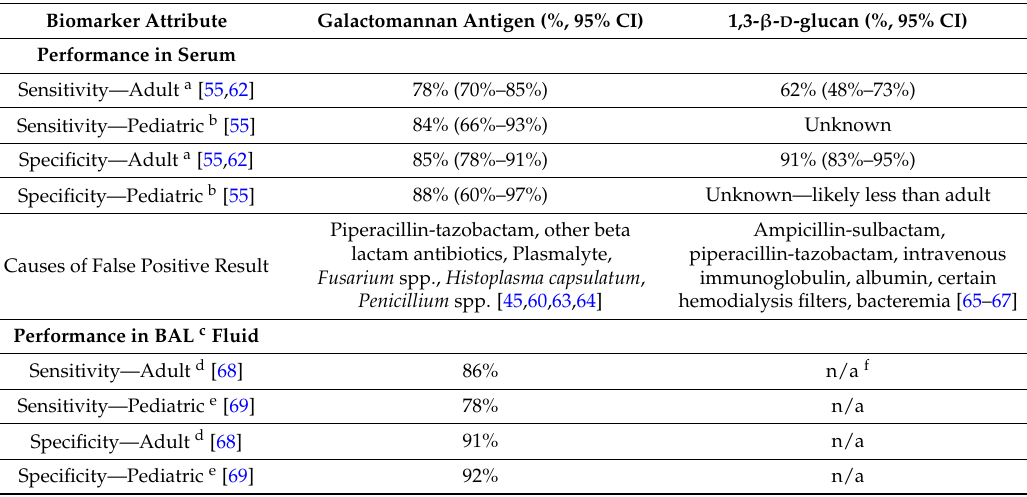
Table 2. Fungal Biomarkers for Diagnosis of Invasive